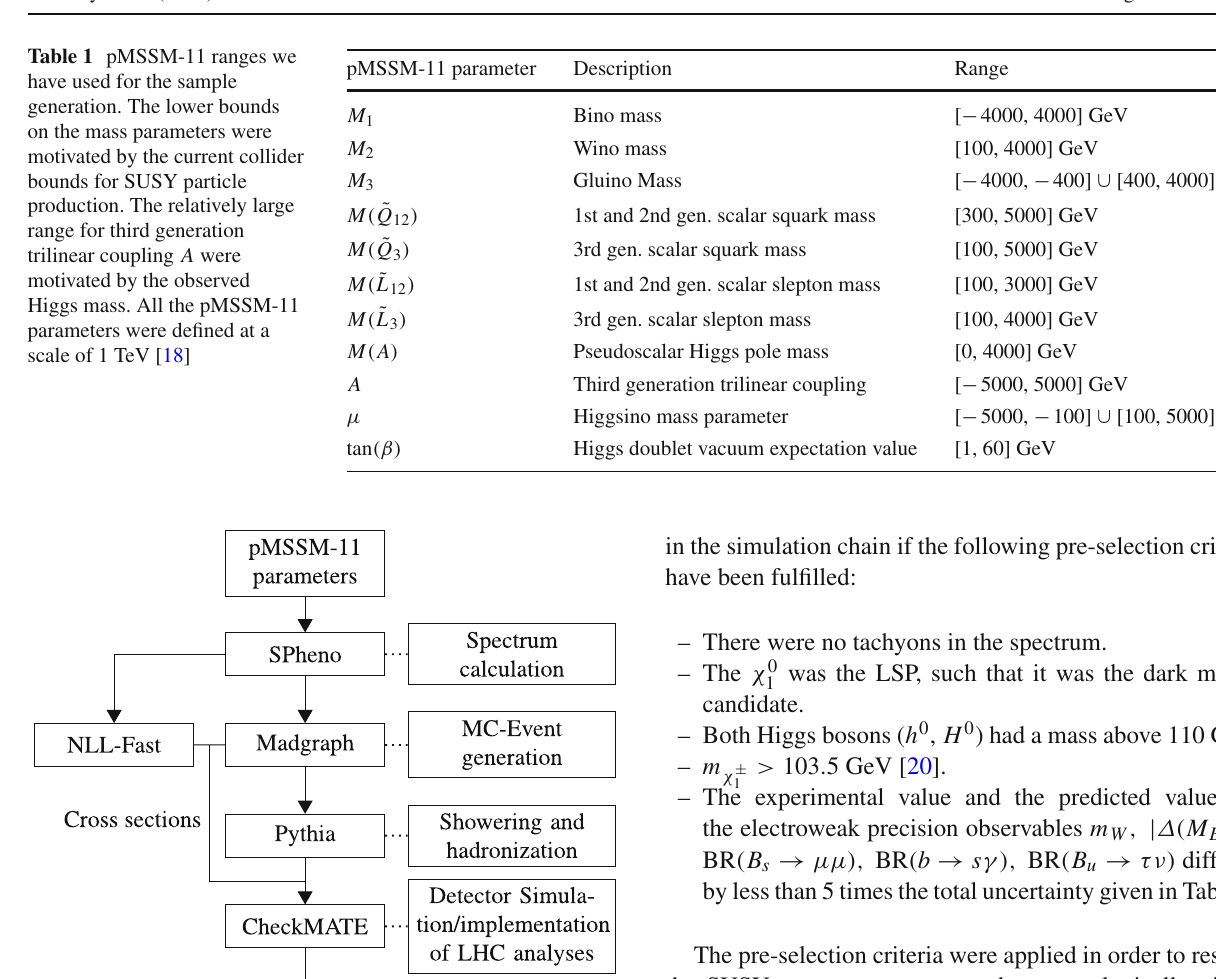
denotes χ 2 -values obtained CM